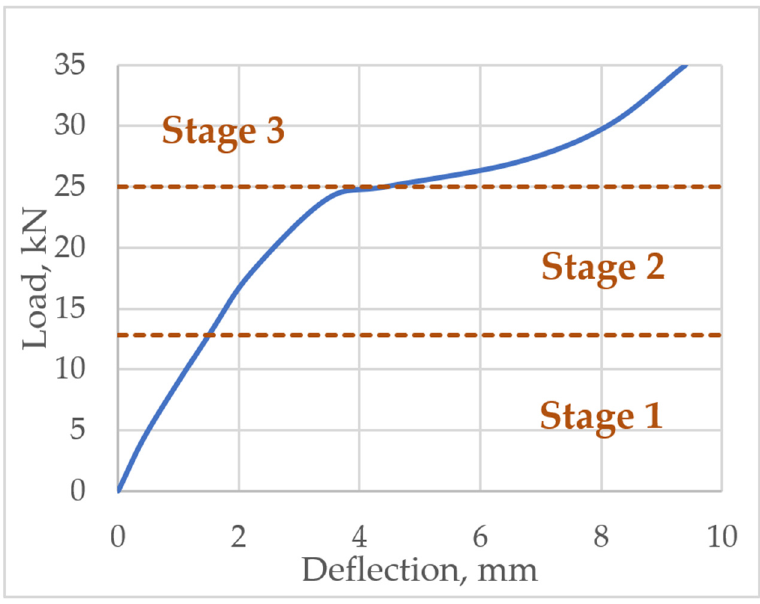
Figure 3. Slab loading